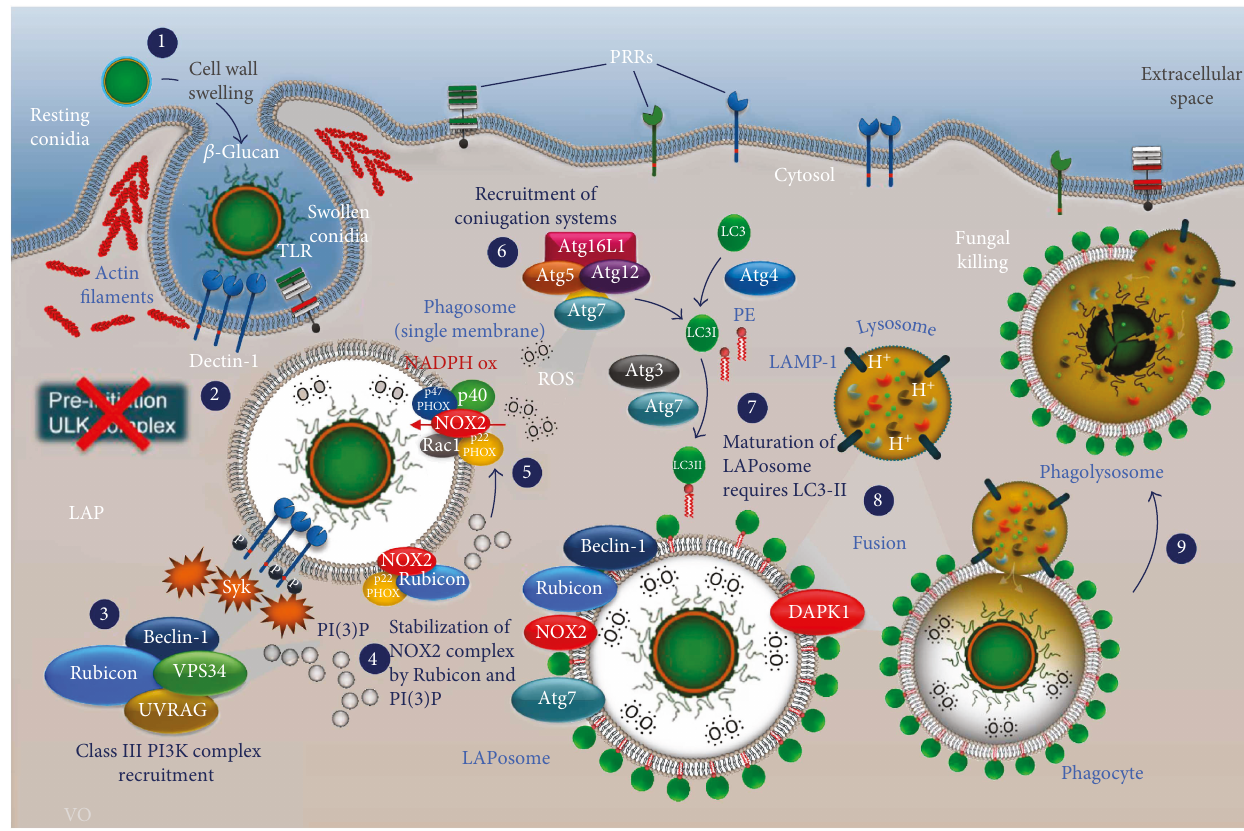
Figure 1: Overview of the LAP pathway during Aspergillus fumigatus infection. (1) Cell wall swelling of resting Aspergillus conidia (exposure of carbohydrate molecules, such as β -glucan) activates innate immune responses in host phagocytes. (2) Pattern recognition receptors (PPRs) on phagocytes (Dectin-1, TLRs) recognize β -glucan and internalize it through phagocytosis. During phagocytosis, swollen Aspergillus conidia trigger the Dectin-1/Syk kinase complex. (3) Subsequent activation of LAP occurs by recruitment of the class III PI3K complex (Rubicon/ UVRAG/VPS34/Beclin-1) to the single-membrane phagosome. (4) The class III PI3K complex generates PI(3)P that localizes to phagosome with subsequent stabilization of the NOX2 complex by Rubicon and PI(3)P. (5) Complete assembly of the NOX2 NADPH oxidase complex is capable in optimal ROS production. (6) PI(3)P formation and ROS production lead to the recruitment of the downstream Atg5/Atg12/Atg16L1 conjugation complex, as well as of Atg7, Atg3, and Atg4, all of which are critical for the lipidation of LC3 (conjugation of LC3I to PE to form LC3II). (7) LAPosome maturation requires LC3II deposition and DAPK1 localization for anti- in fl ammatory activity. Finally, (8) fusion with LAMP-1-lysosome and (9) phagolysosome formation with fungal killing